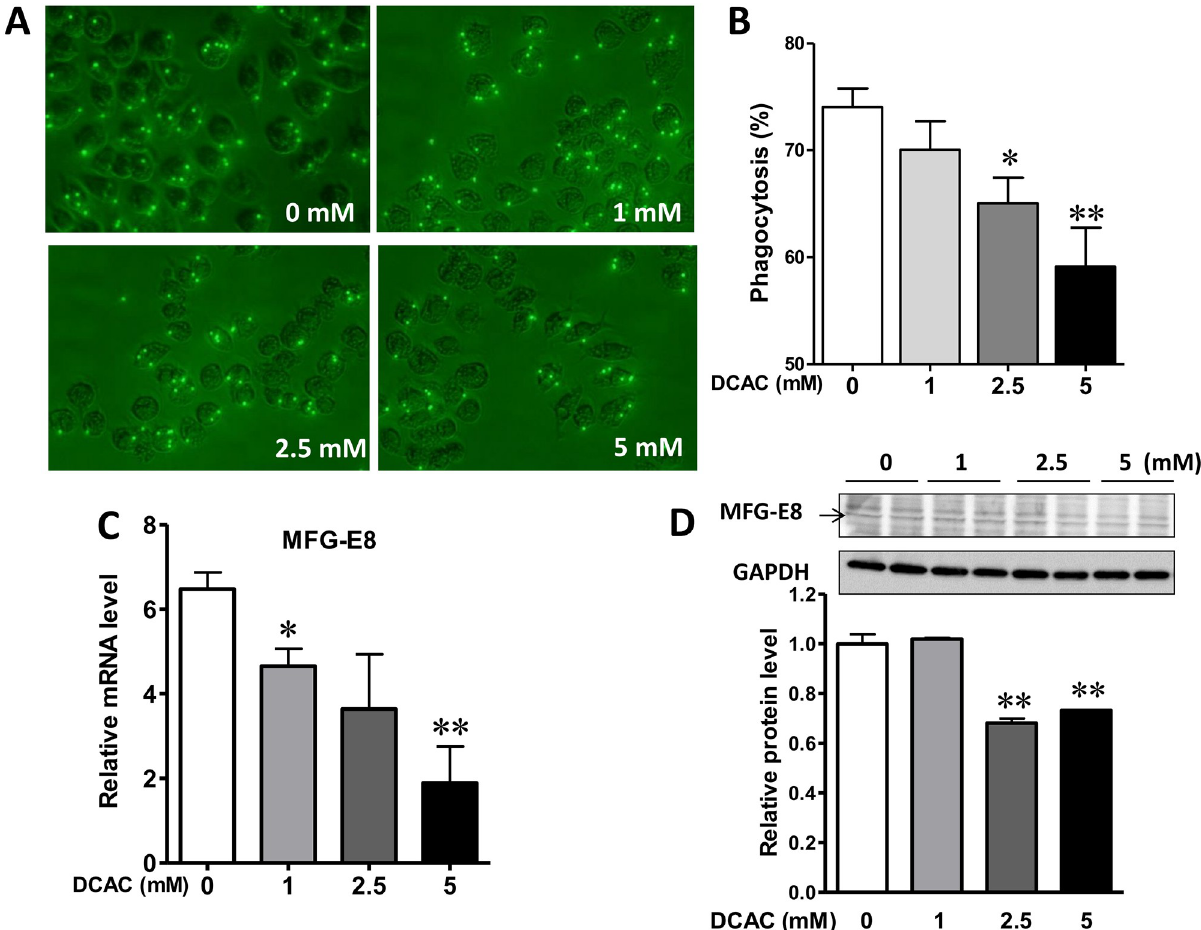
Fig 2. Effect of DCAC on KC phagocytosis. Cells were treated with different concentrations of DCAC for 24 h, and then incubated with fluorescent latex beads for 30 min. (A) Representative images of KCs treated with DCAC (0, 1, 2.5 or 5 mM) for 24 h, showing decreased phagocytic activity after DCAC exposure. (B) The KC phagocytosis was measured by counting the bead-internalized KCs from 10 different fields and the percentage of bead- positive cells was calculated, (C) Relative mRNA level of MFG-E8 (phagocytic function), as measured by RT-PCR, and (D) Relative protein level of MFG-E8, as determined by Western blotting. n = 3 in each group. � p < 0.05; �� p < 0.01, as compared to the control.